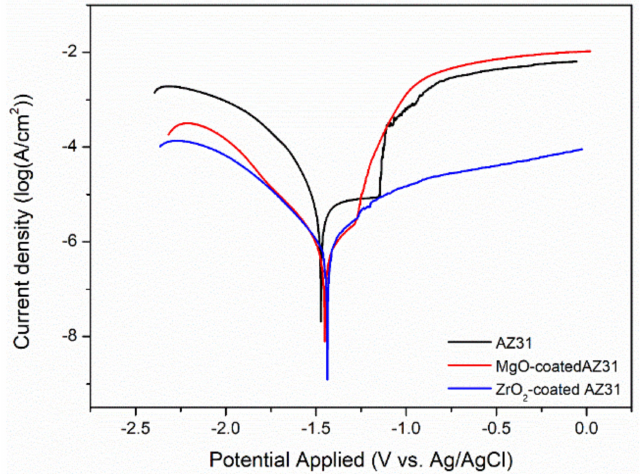
Figure 5. The potentiodynamic polarization curves for AZ31, MgO-coated AZ31, and ZrO 2 -coated AZ31 in simulated body fluid (SBF) at room